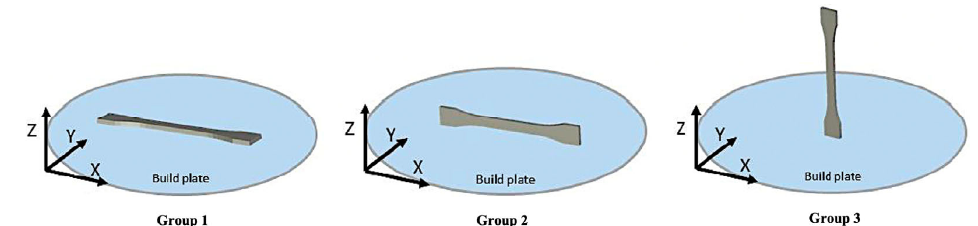
Figure 1. Samples of group A were printed in different XY, XZ, and ZX orientations.